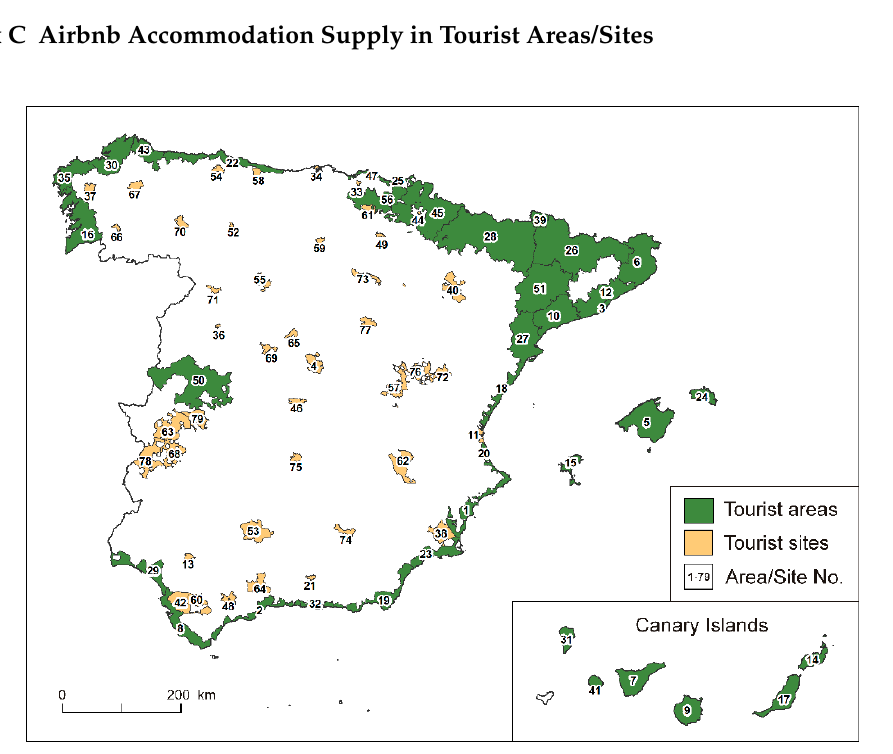
Figure A1. Location of tourist areas/sites described in Table A4.